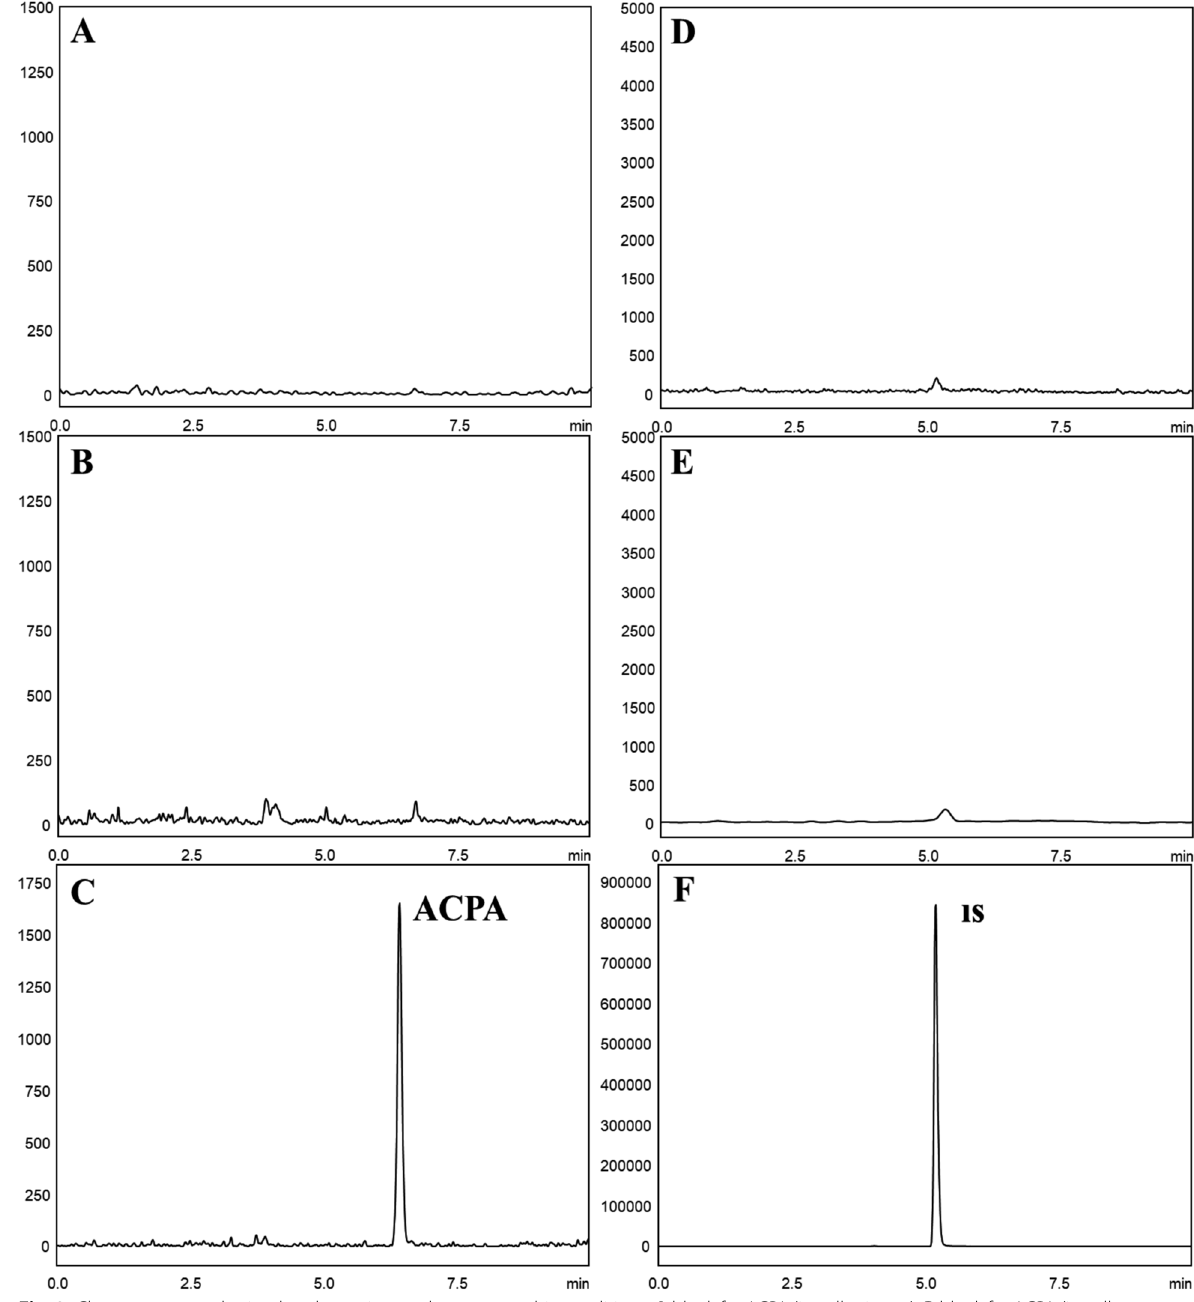
Fig. 3 Chromatograms obtained under optimum chromatographic conditions: A blank for ACPA (in cell mixture), B blank for ACPA (in cell supernatant mixture), C ACPA spiked matrix at LOQ concentration, D blank for IS (in cell mixture), E blank for IS (in cell supernatant mixture), F IS spiked matrix (1000